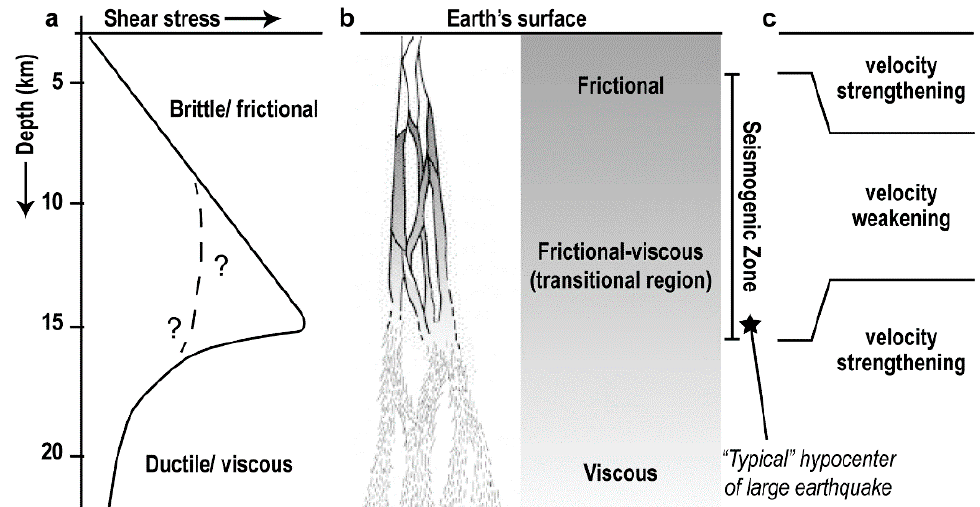
Figure 1. Schematic profile of a fault zone in Earth’s upper-crust. ( a ) Fault strength vs. depth. ( b ) Fault zone sketch (from [15]), with a rough depth range indicating fault deformation regimes, the seismogenic zone, and ( c ) velocity dependence or intrinsic fault stability regimes.